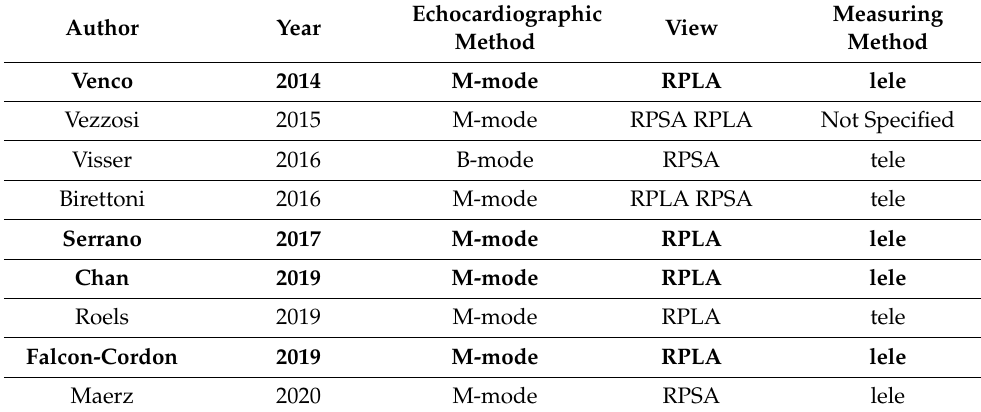
Table 1. RPADi calculation methods published in the veterinary literature. Bold type indicates papers applying the “Venco” method. RPLA, Right Parasternal Long Axis; RPSA, Right Parasternal Short